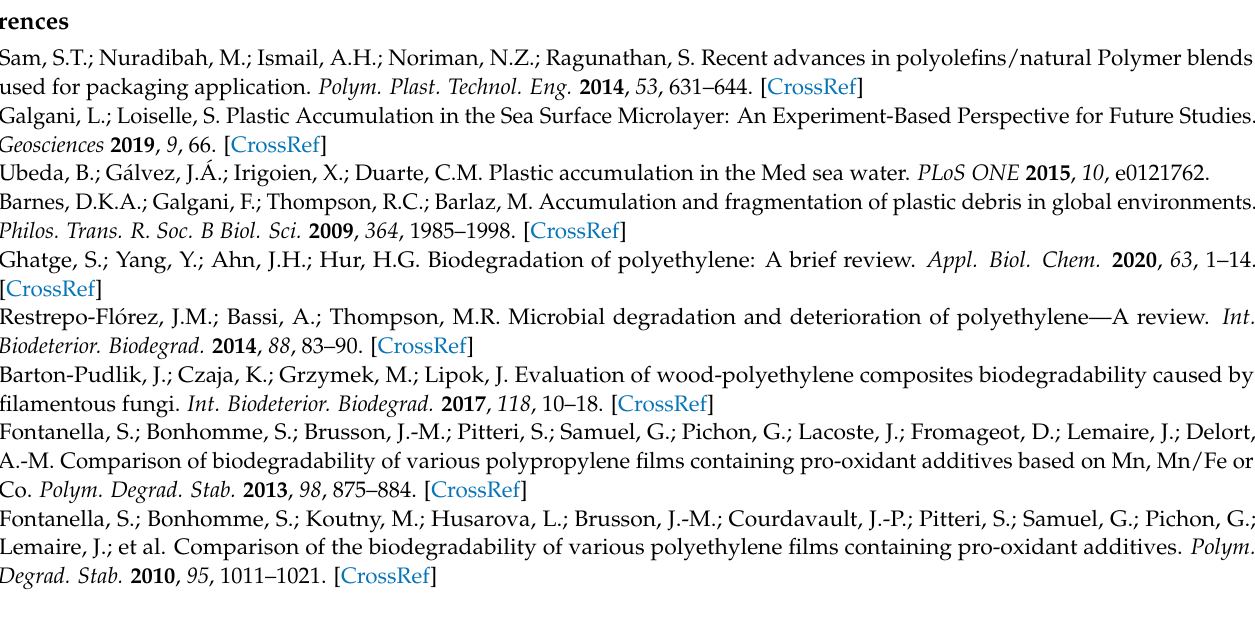
Michelis Menten elaboration according to a Lineweaver Burk plot of the biodegradation data of material C. Red void symbols represent a zoom of the linearization used, Figure S8: Zero order kinetic equation for the biodegradation data of material C, Figure S9: Second order kinetic equation for the biodegradation data of material